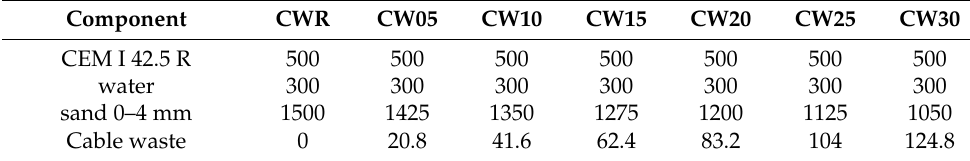
Table 1. Composition of studied